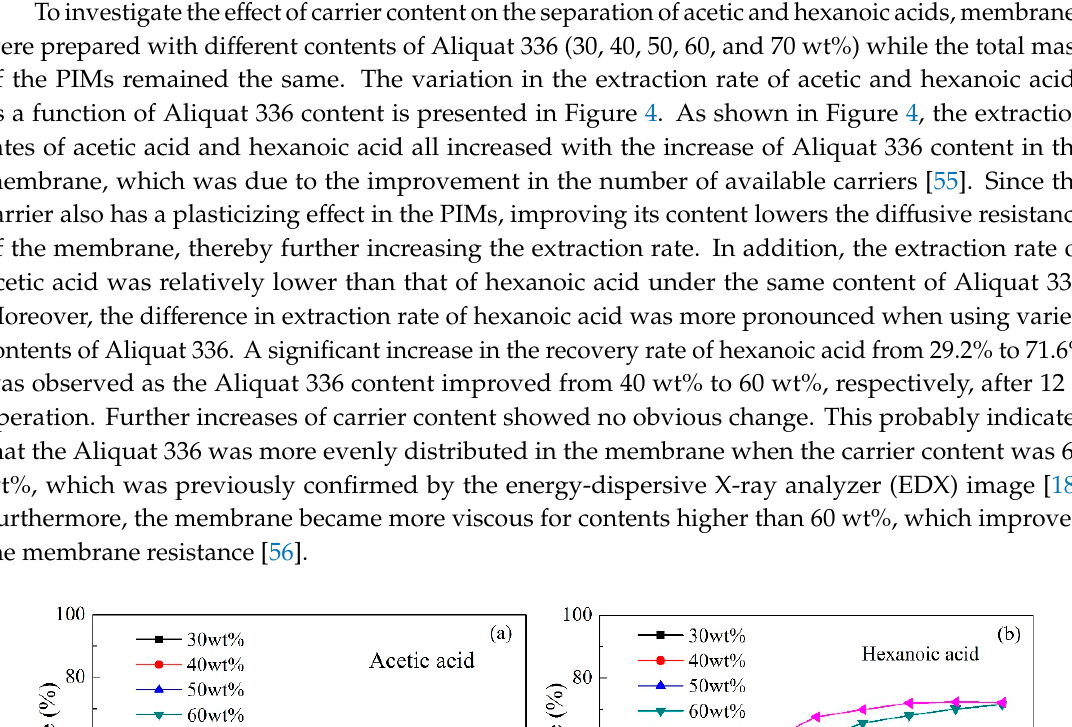
Figure 5. The permeability coefficient of acetic and hexanoic acid by PIMs with different Aliquat 336 content (PIMs: PIMs: PIM1, PIM2, PIM3, PIM4, and PIM5; Feed solution: 0.01 mol L − 1 acetic acid +0.01 mol L − 1 hexanoic acid, pH = 6; Stripping solution: 0.1 mol L − 1 HCl). 2.5. Effect of Initial pH in Feed Solution